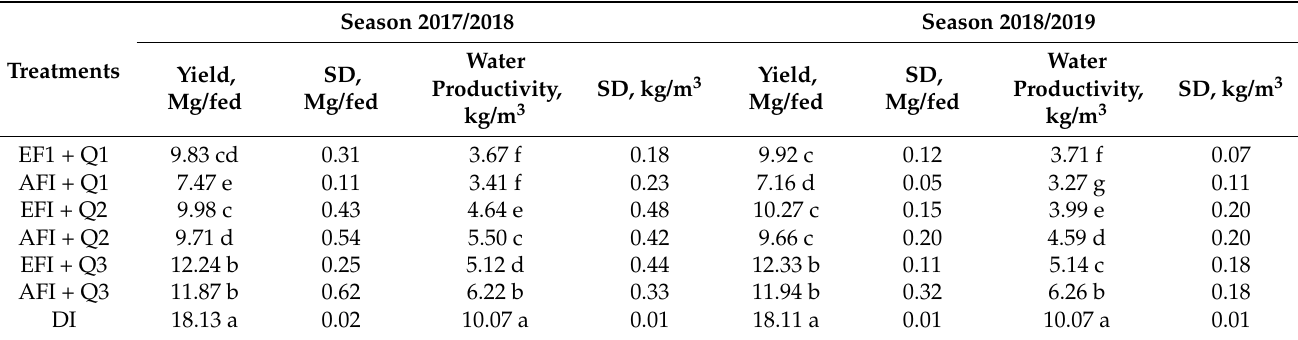
Table 4. Effect of irrigation methods (EFI, AFI, and DI) and flow rates (0.47 (Q1), 0.95 (Q2), and 1.43 L/s (Q3)) on yield and water productivity in the first and second growing seasons.